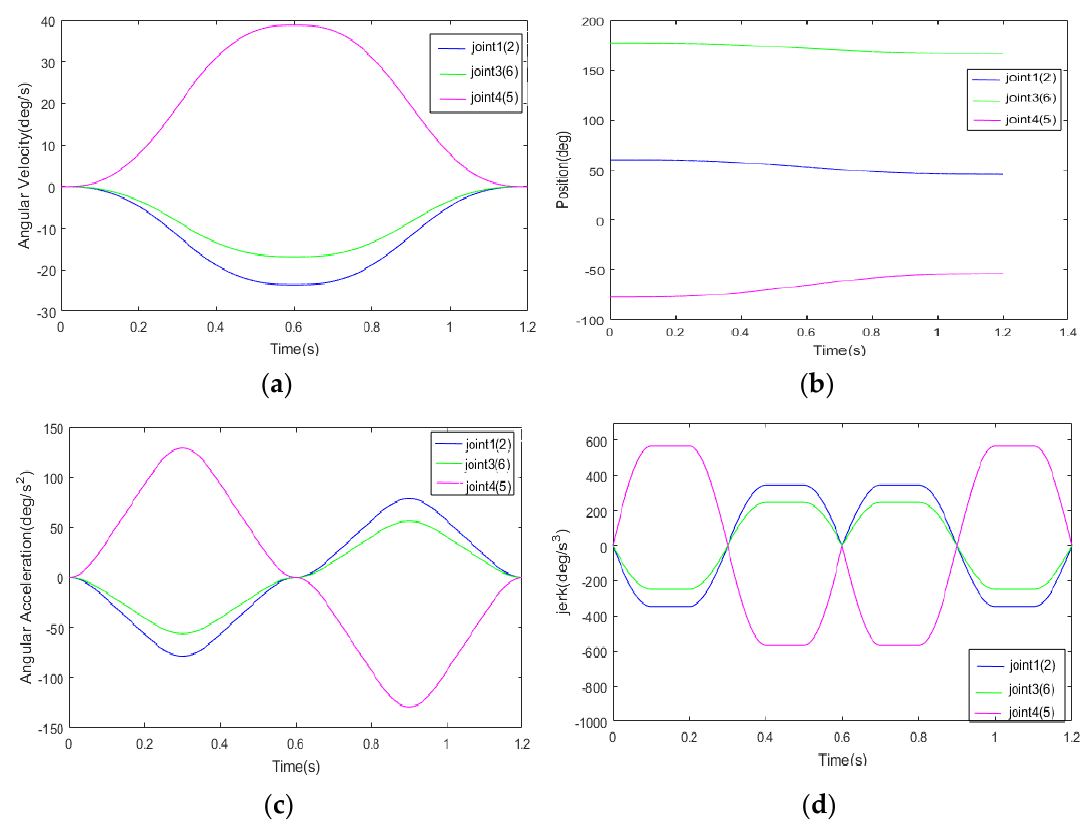
Figure 5. Curves of angular displacement, angular velocity, angular acceleration, and angular acceleration rate of each joint: ( a ) angular displacement curve of each joint, ( b ) angular velocity curve of each joint, ( c ) angular acceleration curve of each joint, and ( d ) angular acceleration rate of each joint.